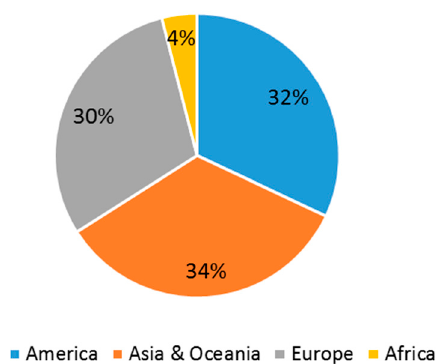
Figure 25. Continental distribution of studies on the structural performance of foam-filled composite